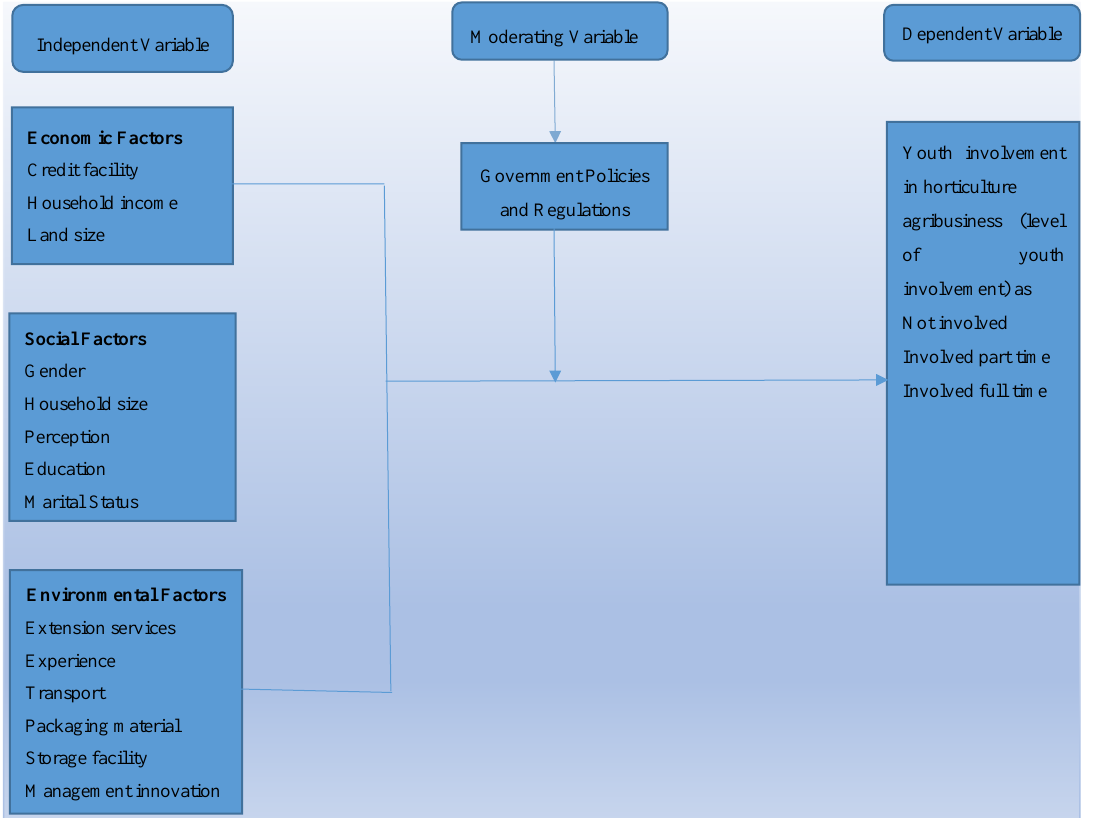
Figure 1. Conceptual Framework. Source: Modified from